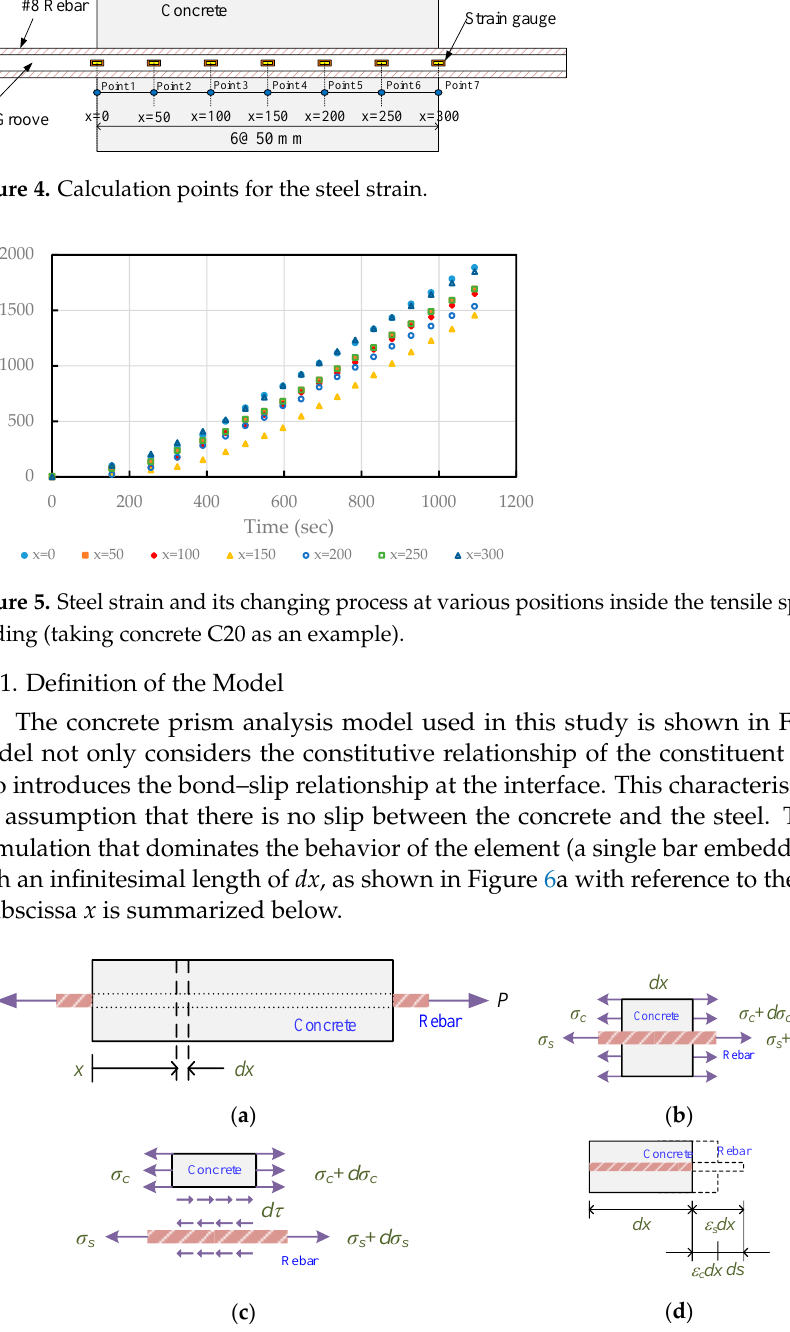
Figure 6. Analytical model: ( a ) diagram of tension – pull specimen, ( b ) equilibrium of prism, ( c ) equilibrium at interface, and ( d ) compatibility of deformations.